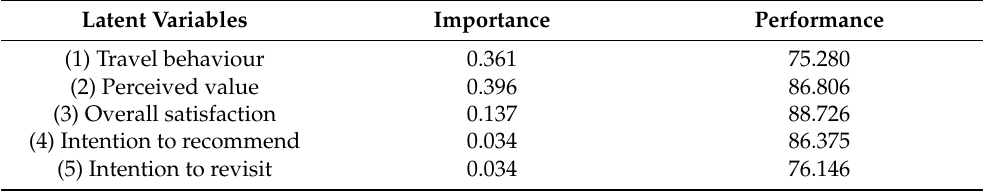
Table 4. Importance-performance map analysis for perceived